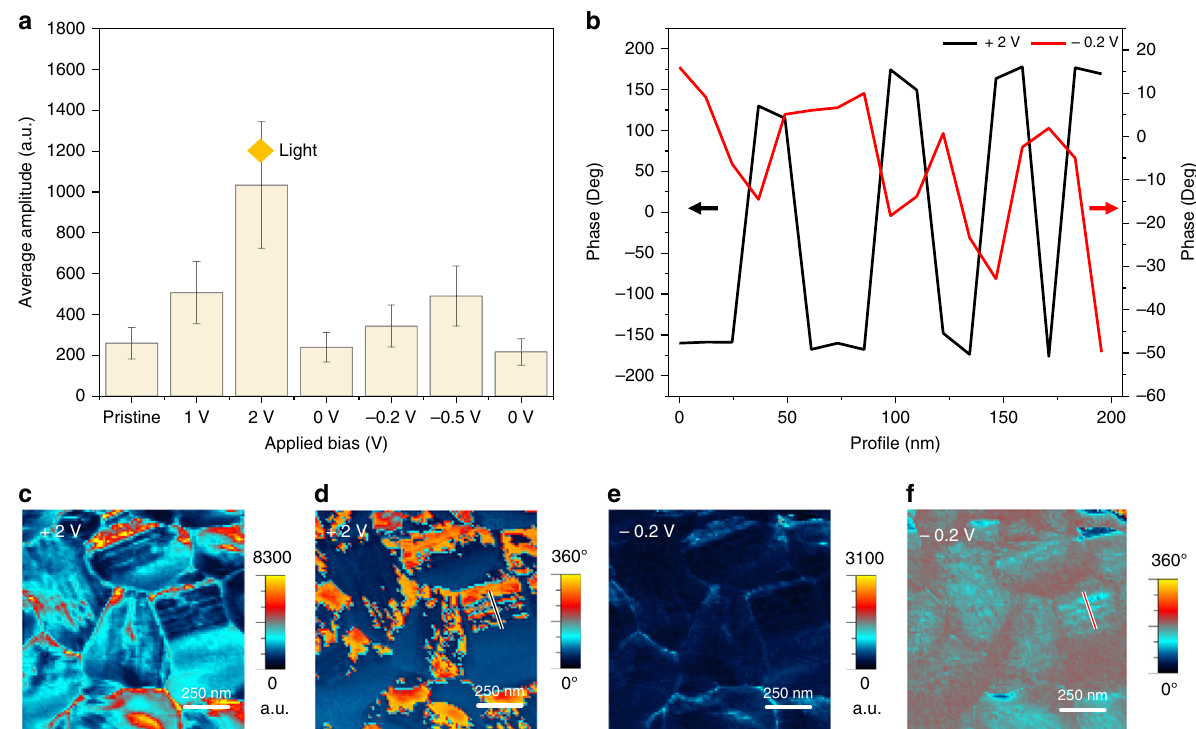
Fig. 3 Effect of applying positive and negative bias to the fi lm surface. a Graph of average amplitude signals under different bias. b Line pro fi le of black line in d , and red line in f ; PFM c out-of-plane amplitude map and d out-of-plane phase map under bias voltage of + 2 V; e out-of-plane amplitude map and f out-of-plane phase map under bias voltage of − 0.2